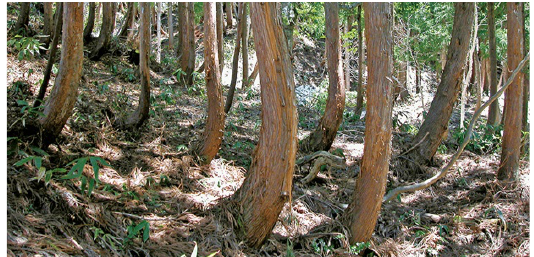
Figure 2. Non-vertical trees